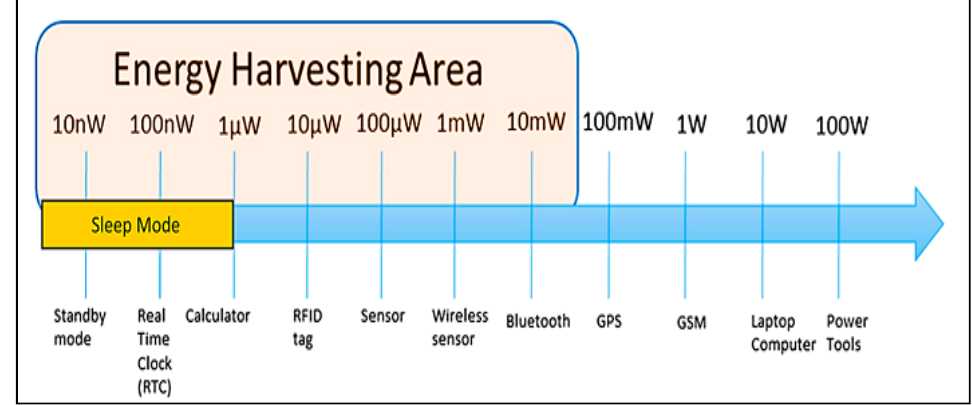
Figure 31. Levels of power for portable electronic devices and harvesting of energy capabilities of PV cells for indoor uses. cells for indoor